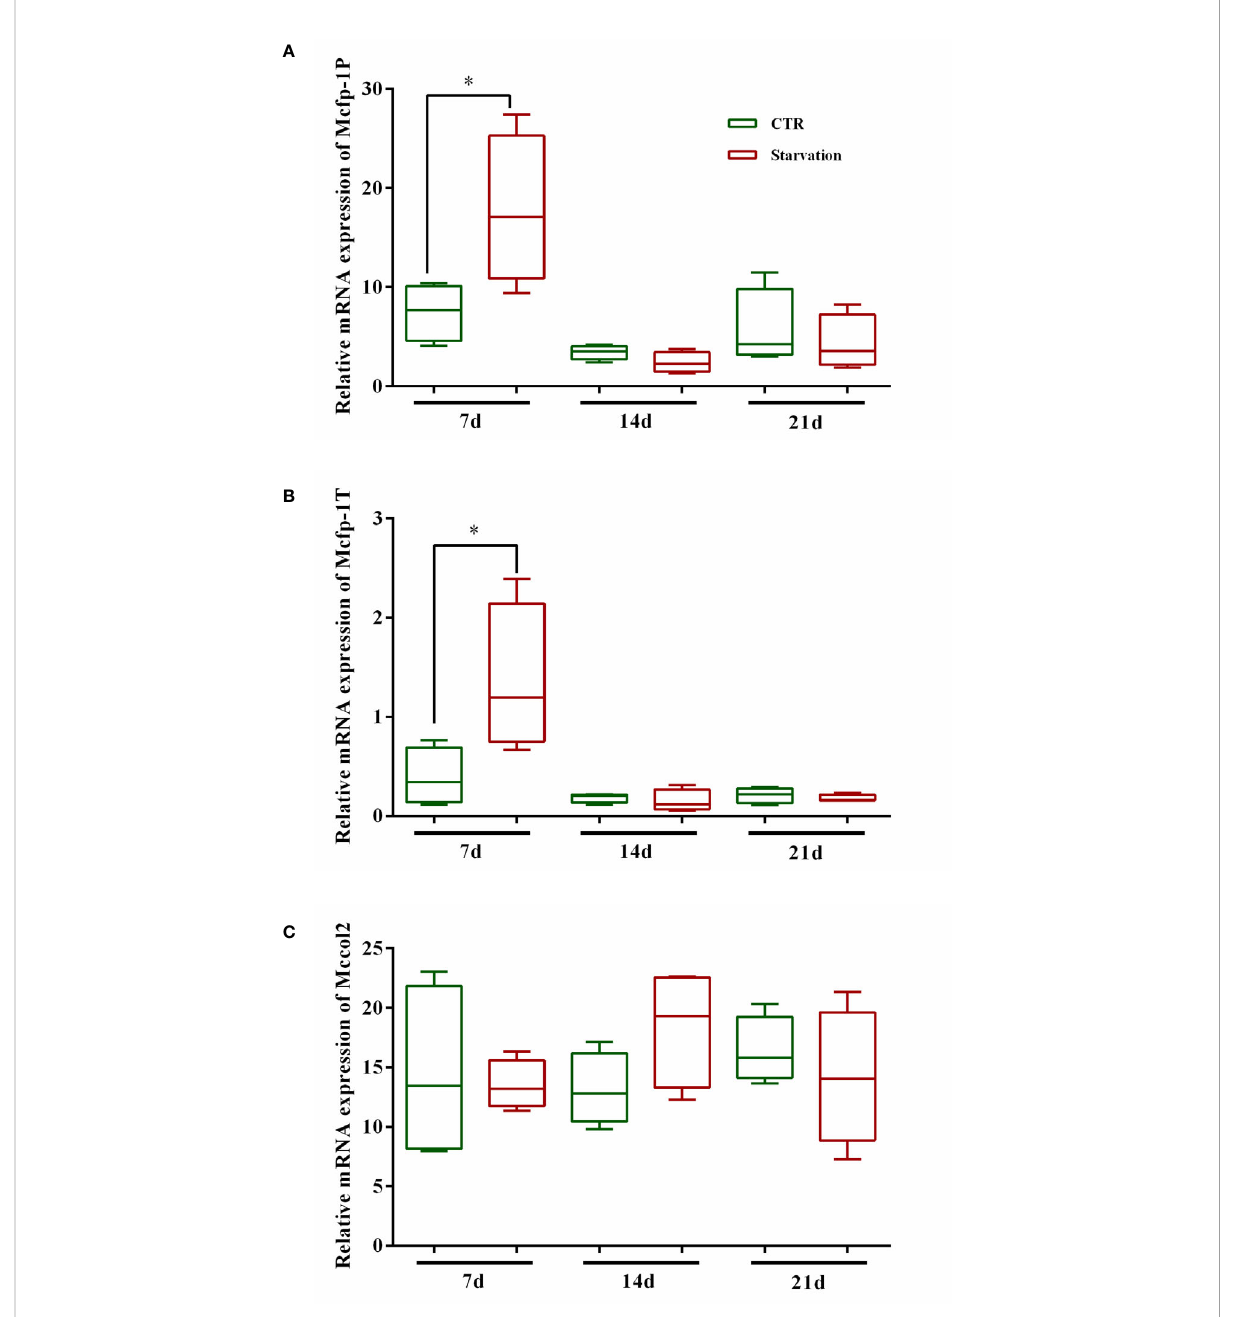
FIGURE 5 Effects of 21 days of starvation on gene expressions of mfps in foot tissue of M. coruscus . Mcfp-1P : adhesive plaque matrix protein; Mccol2 : byssus collagen protein 2; Mcfp-1T : thread protein. CTR: control group. The results of statistical signi fi cance of the starvation groups compared to the control group were marked with asterisks above the columns. * p <